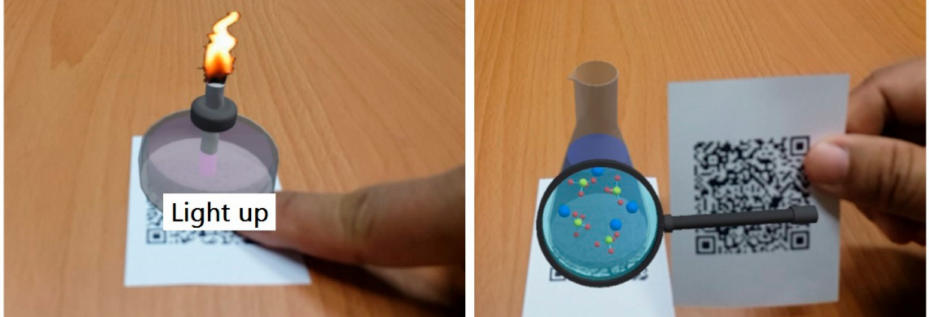
Figure 7. Interaction of 3D objects via the virtual button and QR code identification.